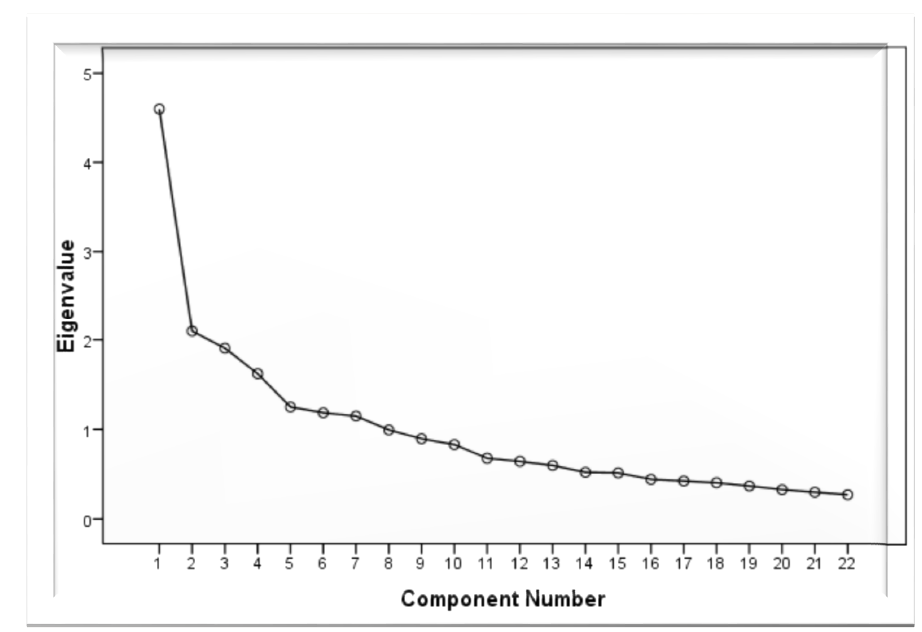
Fig. 1. The results of Scree